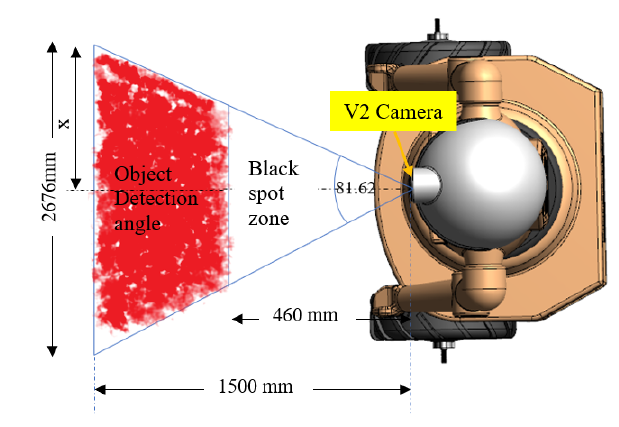
Figure 8. Camera detection zone (top